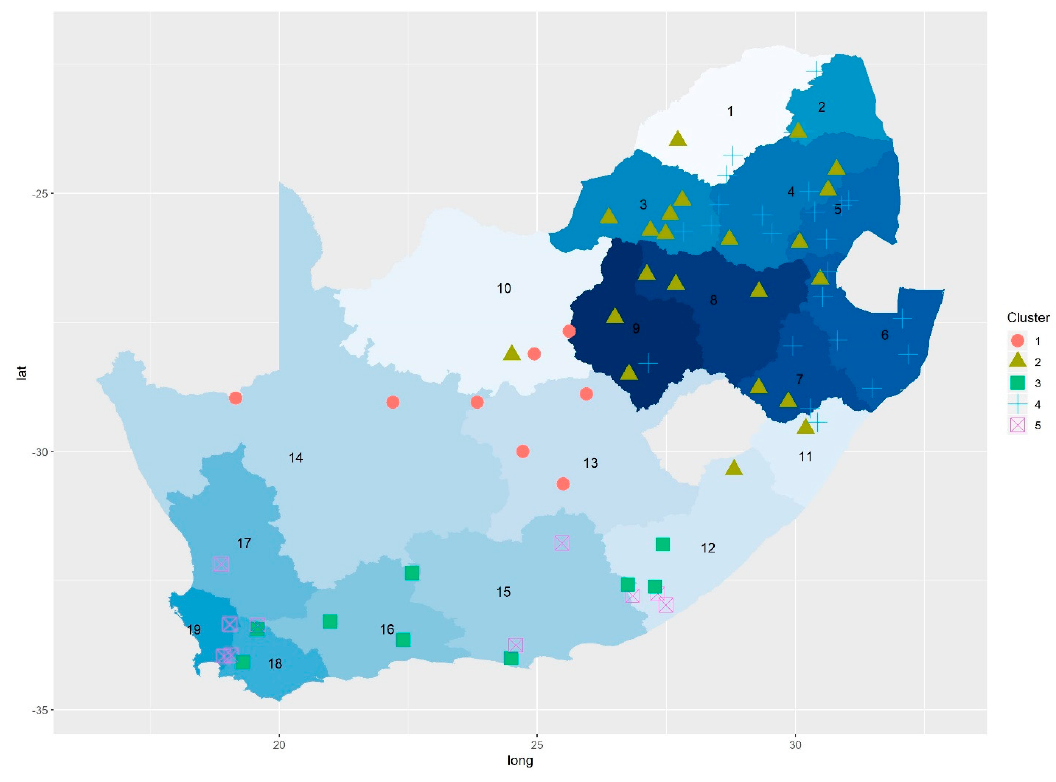
Figure 12. Spatial dependence of drought conditions based on K-means clustering. The underlying colors depict the different WMAs (denoted by the different).